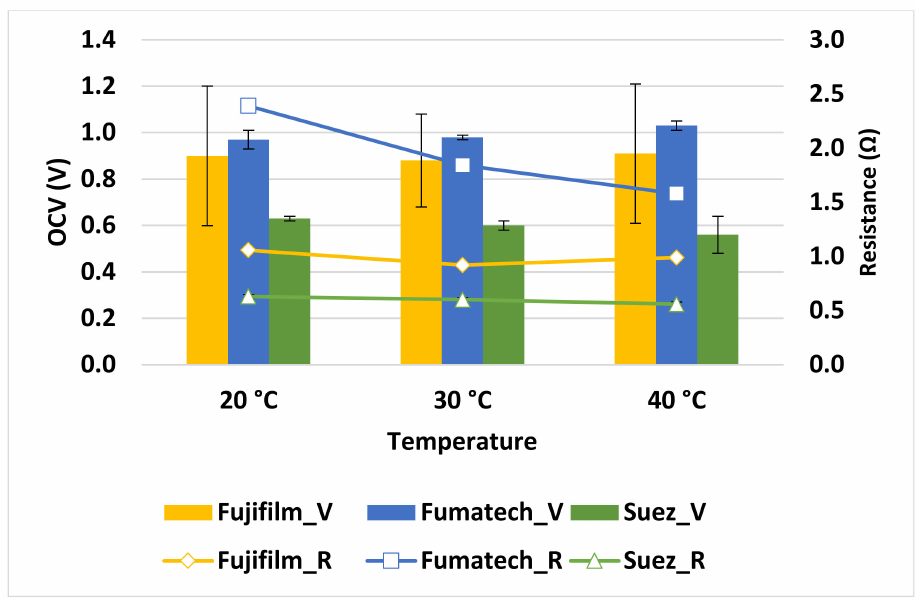
Figure 7. Variation of OCV and stack resistance with temperature under the experimental conditions of 5 mol L − 1 C High , 0.06 mol L − 1 C Low , and 1 cm s − 1 flow